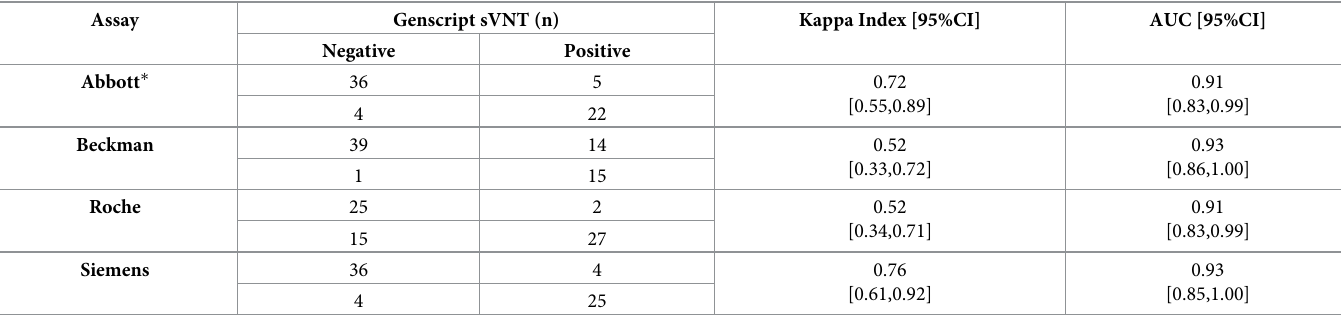
AUC, Area under curve; sVNT surrogate virus neutralization